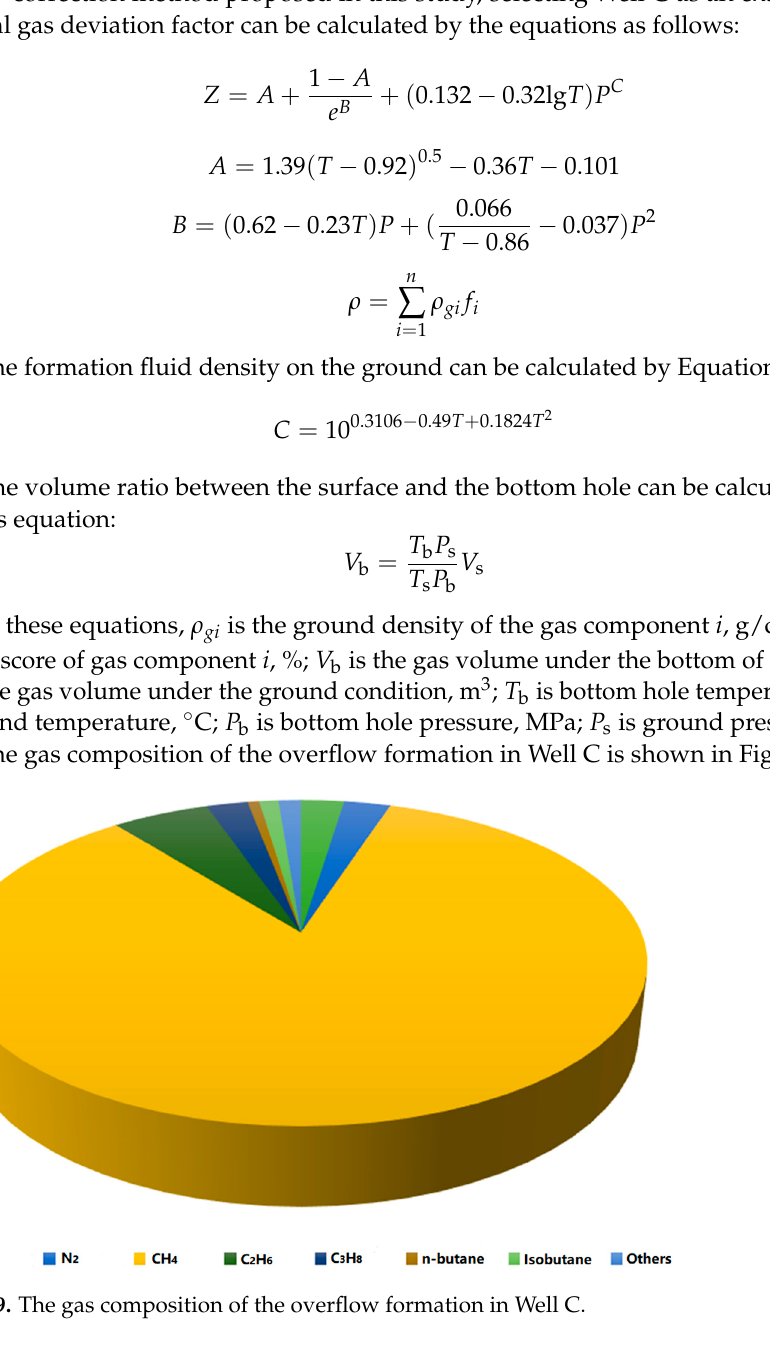
Figure 9. The gas composition of the overflow formation in Well C.